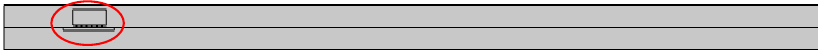
Figure 2. Two-dimensional model for EMUS surface wave detection.